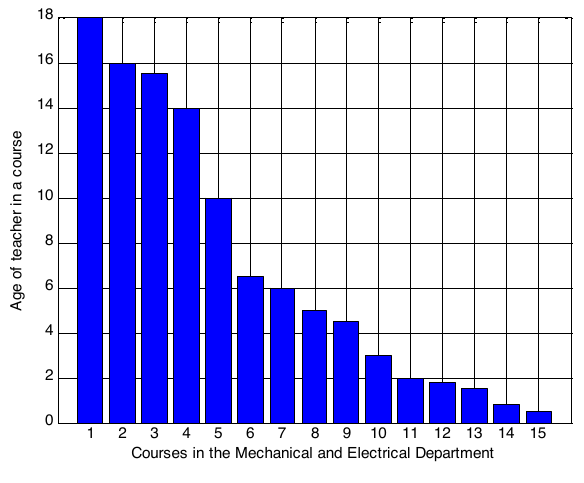
Figure 2. Age of teacher in a course